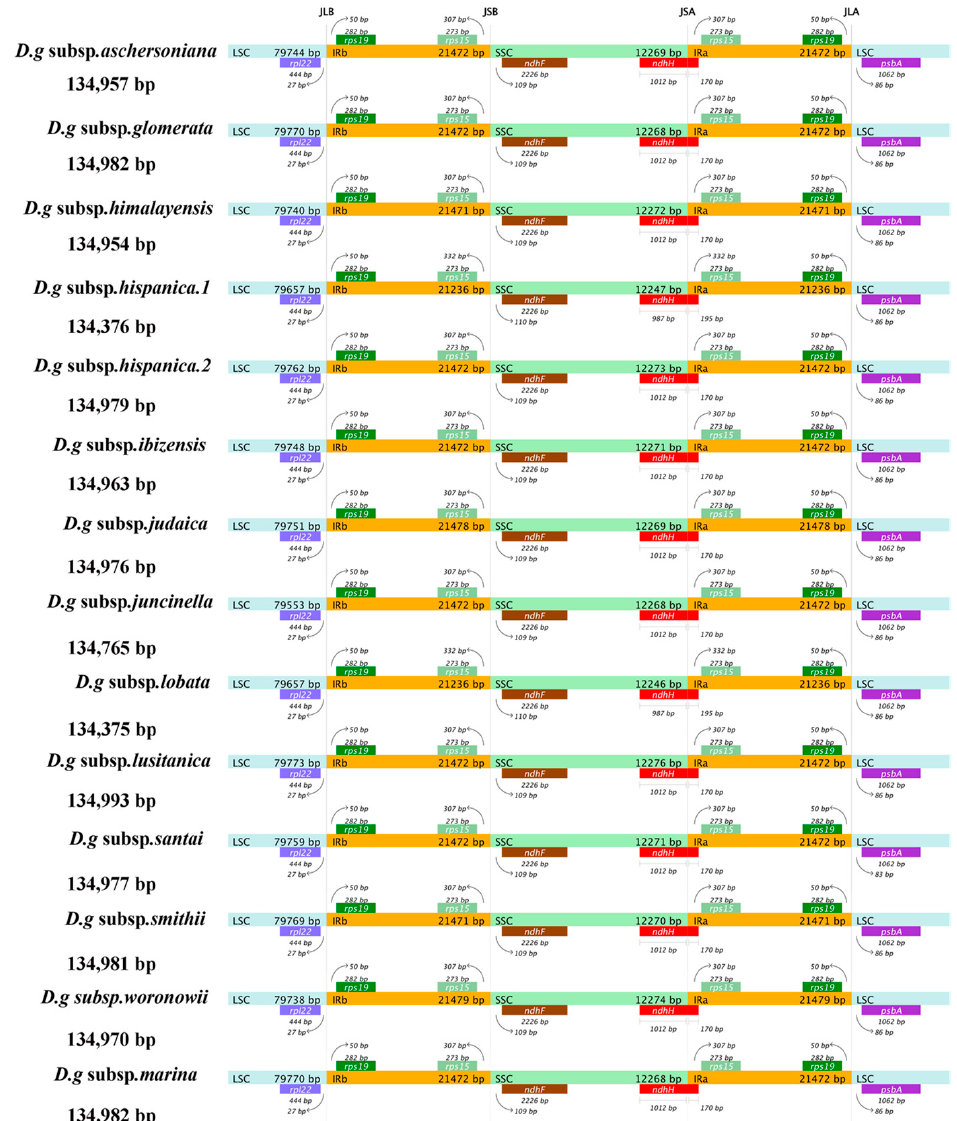
Figure 3. Comparison of the boundaries of LSC, SSC, and IR regions within cp genomes of 14 D. glomerata subspecies. Genes are denoted by bars, the gaps between the genes and the boundaries are indicated by the base lengths (bp). Extensions of the genes are indicated above the bars.